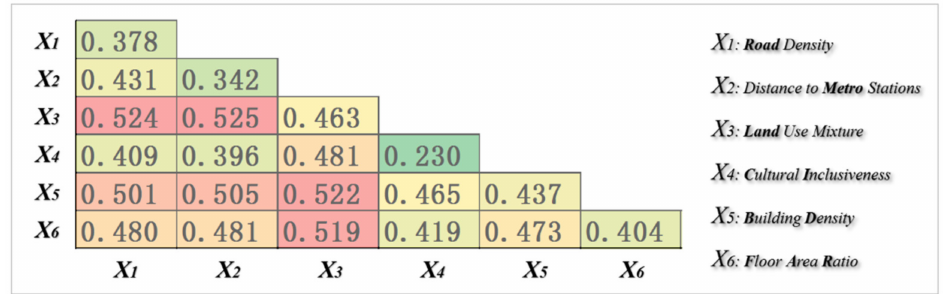
Figure 8. Interactive effects of determinants on